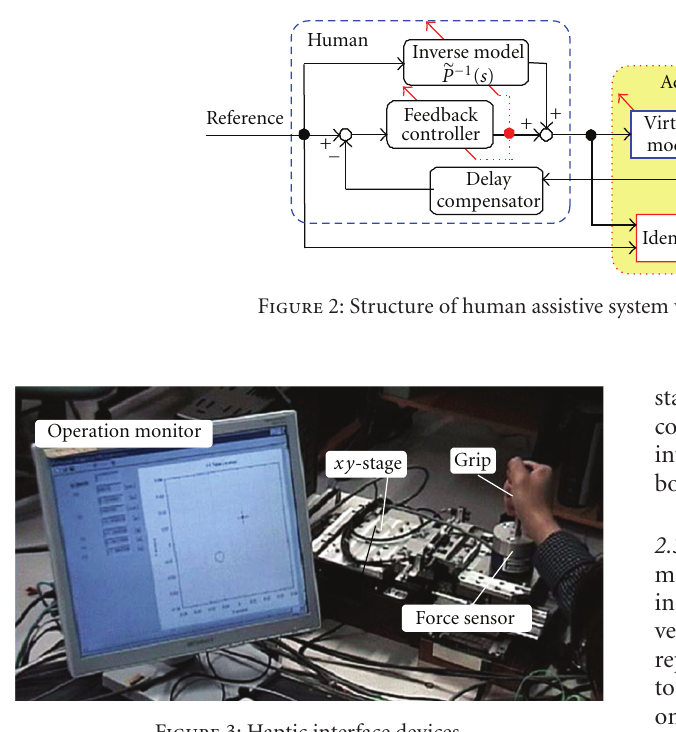
Figure 3: Haptic interface devices.